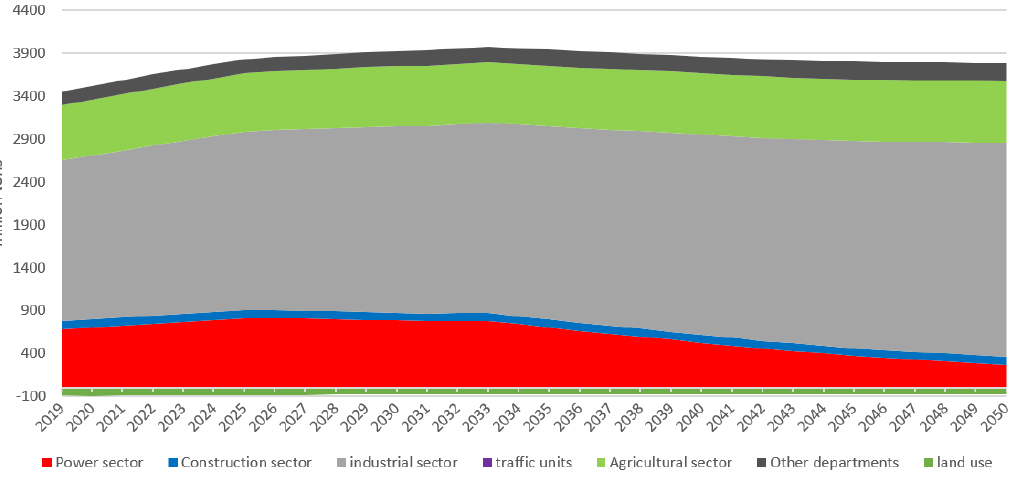
Figure 16. Change of carbon dioxide emissions in Inner Mongolia under the scenario of early re-tirement of coal power units.